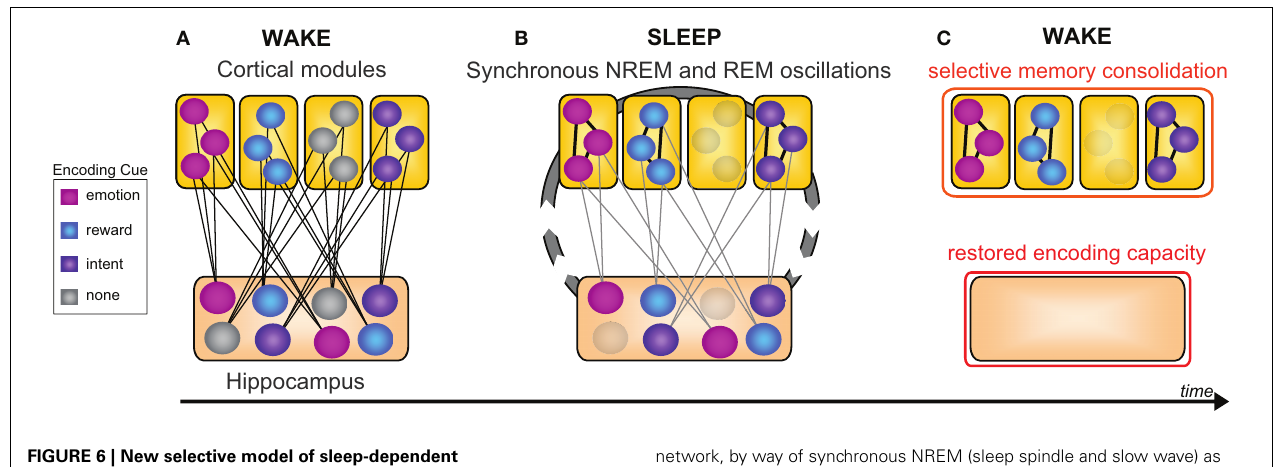
FIGURE 6 | New selective model of sleep-dependent hippocampal-neocortical memory consolidation. (A) At encoding the hippocampus rapidly integrates information within distributed cortical modules, however certain memories (colored nodes) are weighted over others by means of relevant information (e.g., emotion, reward, or intention), whereas other memories lack this relevance tag (gray nodes). (B) Successive sleep-dependent reactivation of this hippocampal-cortical